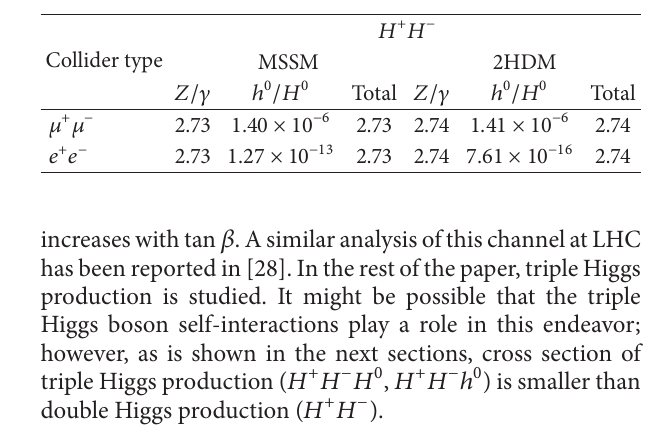
Figure 3: Total cross section 𝜎(𝐻 + 𝐻 − ) (in fb) as a function of √𝑠 for the tree-level Higgs boson pair production at 2HDM or MSSM at a muon collider.